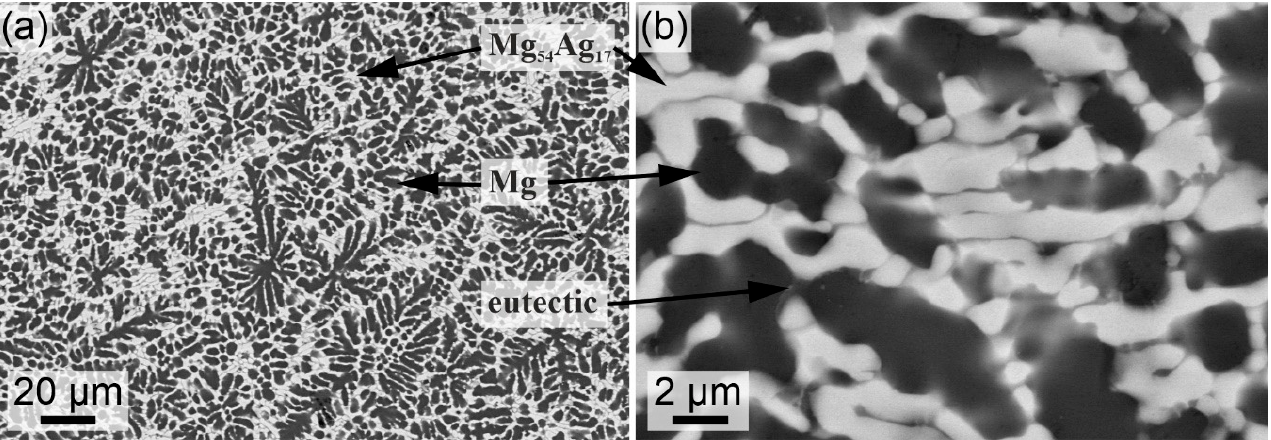
Figure 3. Microstructure of the rapidly solidified Mg 67 Ag 33 alloy: ( a ) a secondary electron micrograph depicts hcp Mg dendrites surrounded by a phase mixture. ( b ) The secondary electron micrograph at higher magnification highlights the structure of the interdendritic phase.